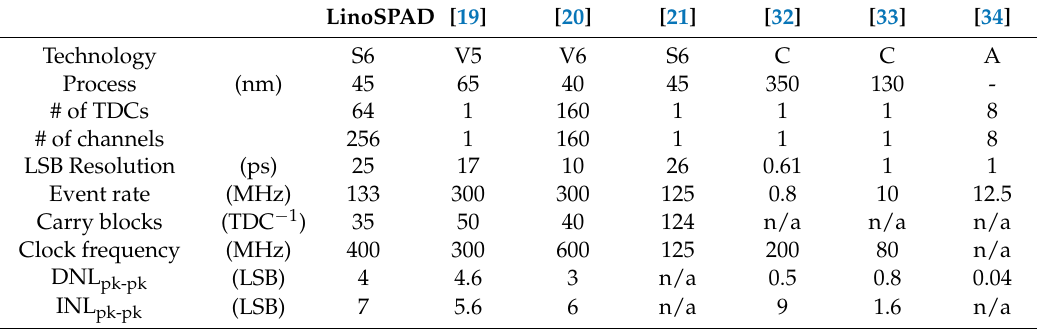
Table 3. LinoSPAD TDC comparison. The stated INL/DNL peak-to-peak ranges are uncorrected values. Technology key: S6, Spartan 6; V5, Virtex 5; V6, Virtex 6; C, CMOS ASIC; A, Unspecified